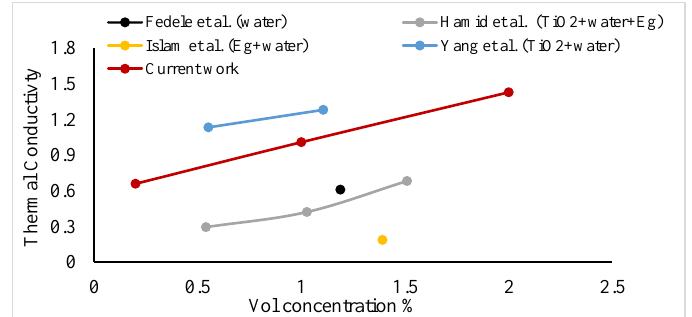
Figure 21. Interaction of the thermal conductivity with Nanofluid concentration. Energies 2021 , 14 , x FOR PEER REVIEW